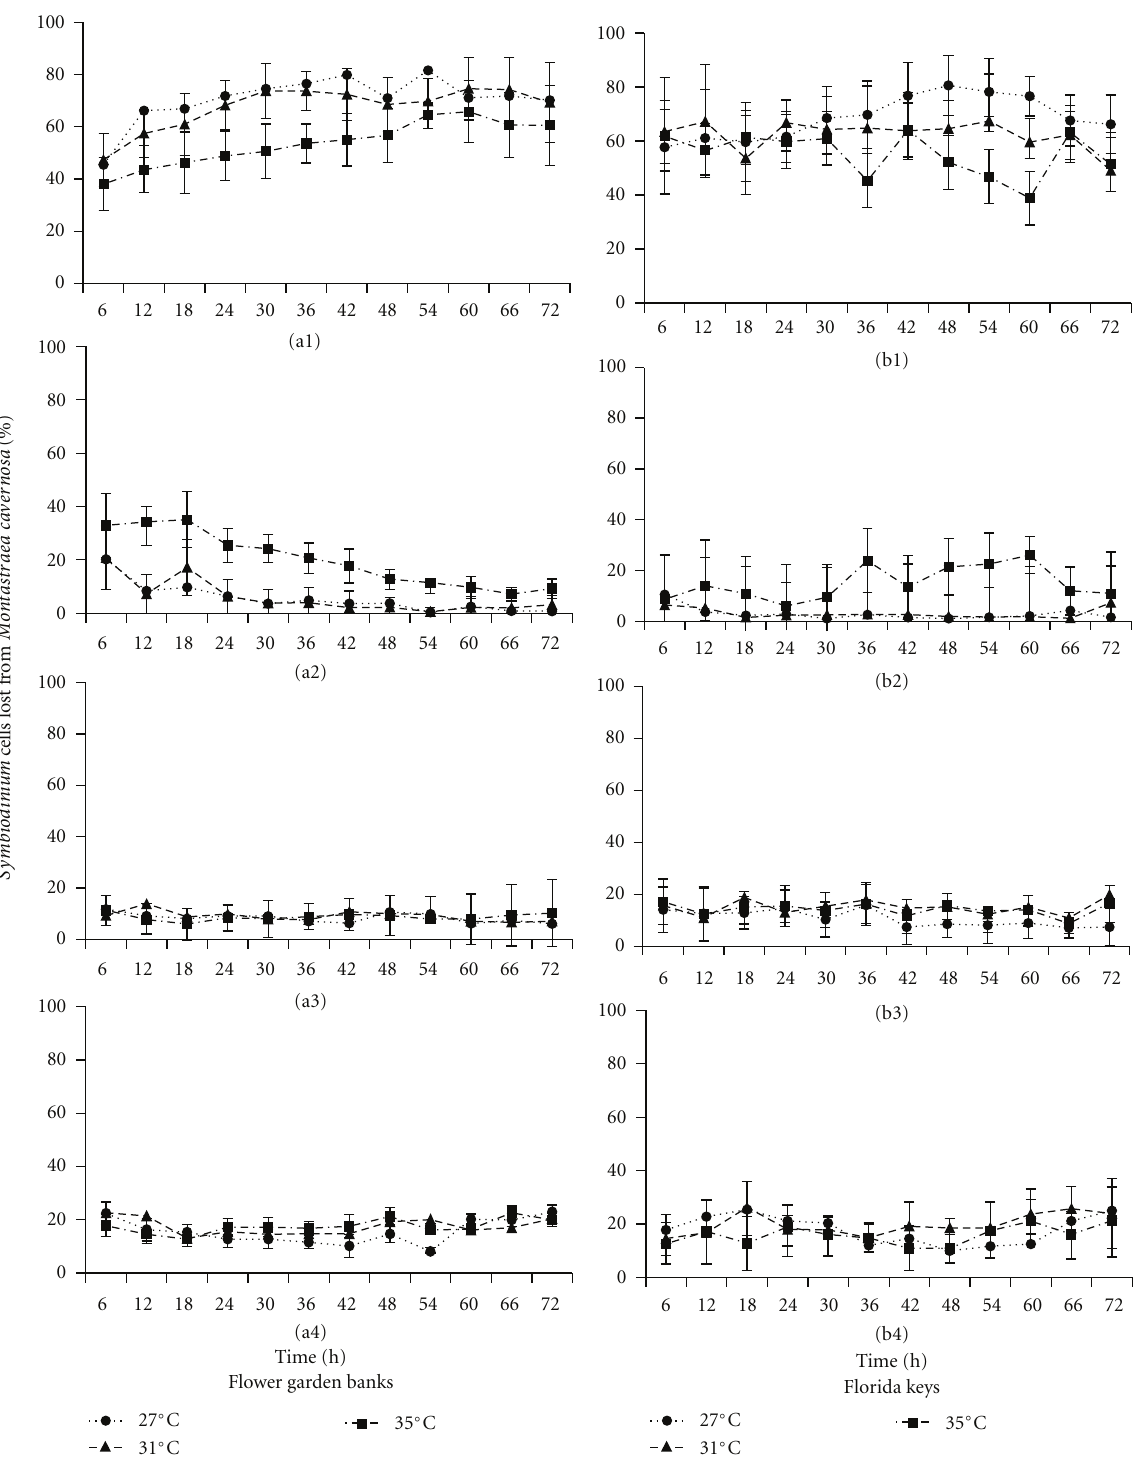
Figure 5: Flow cytometry data showing the mean temporal loss expressed as a percent (%) of viable (a1, b1), necrotic (a2, b2), apoptotic (a3, b3), and postapoptotic (a4, b4) Symbiodinium cells expelled from Montastraea cavernosa collected from the Flower Garden Banks